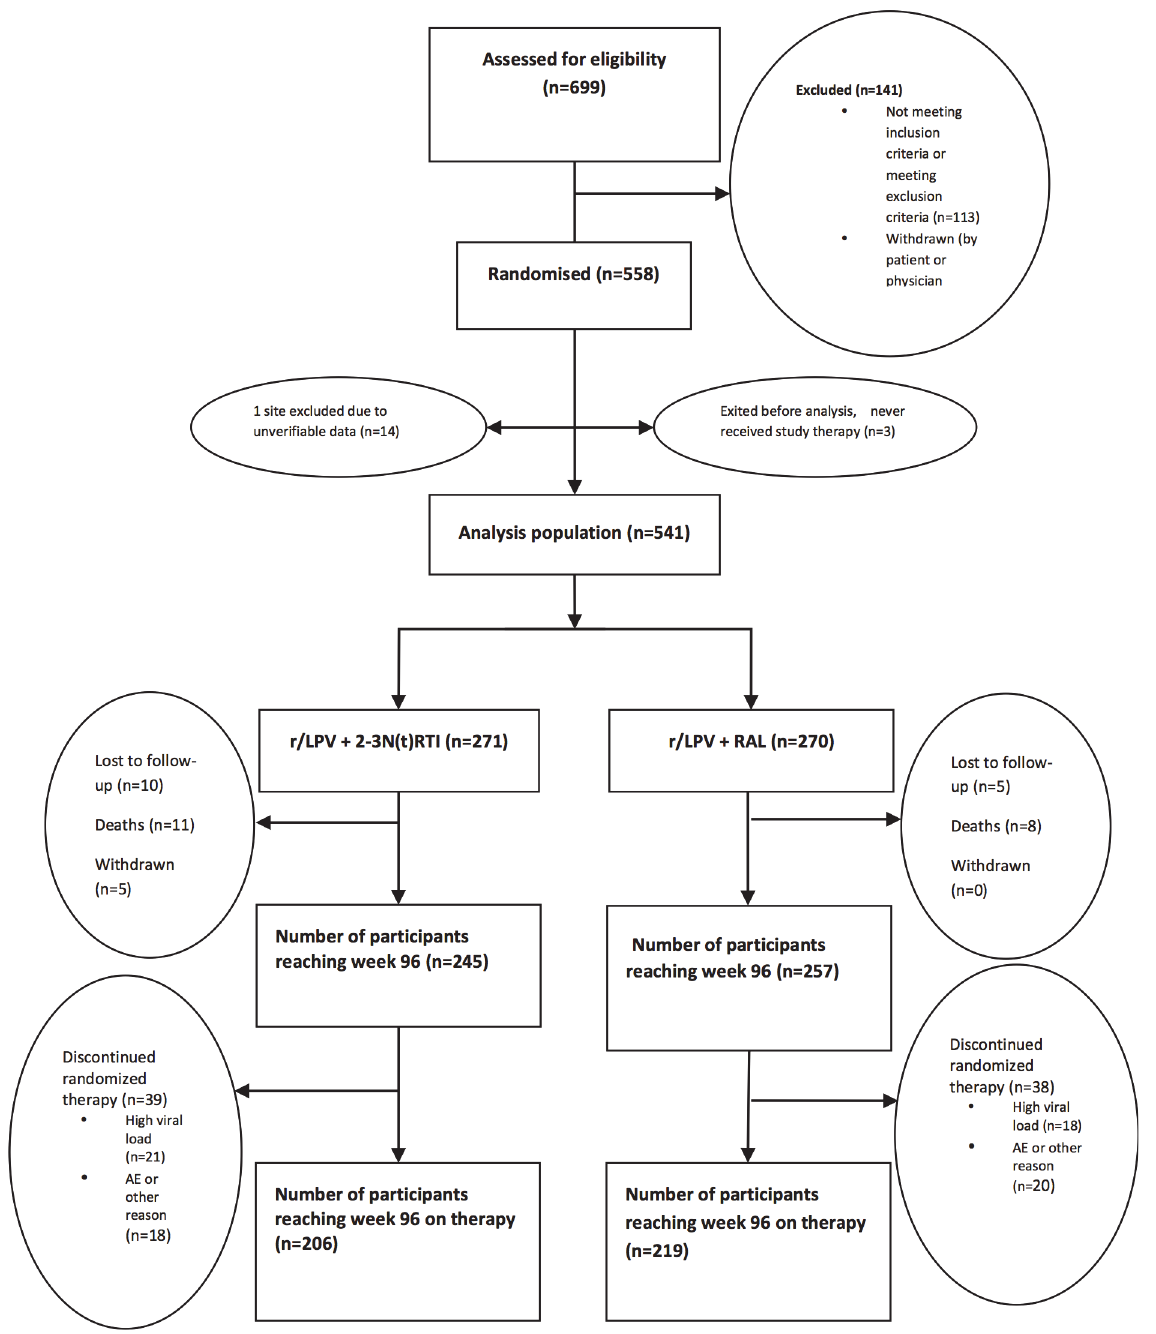
Fig 1. Participant disposition over 96